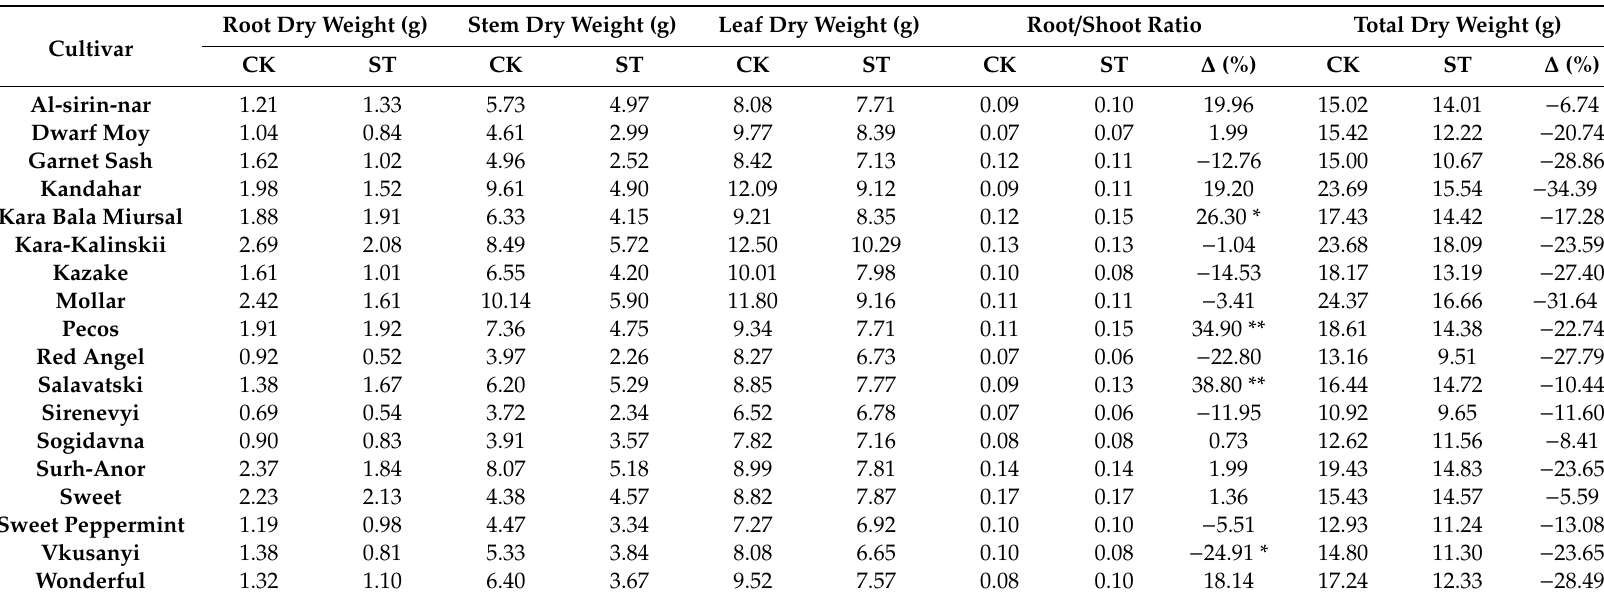
Table 1. Dry weight of roots, stems, and leaves, root / shoot ratio and total day weight of pomegranate plants under NaCl